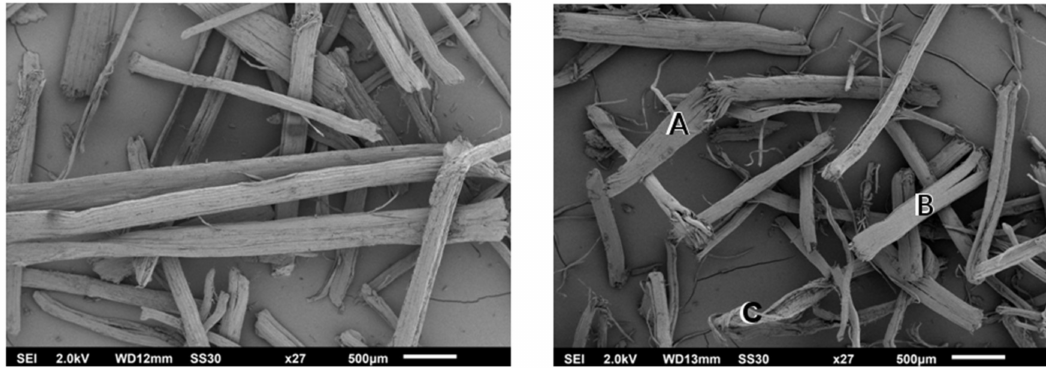
Figure 5. SEM pictures of sisal fibre bundles before ( left ) und after compounding ( right ). A: Fibre bundle breakage. B: Start of fibre bundle splitting. C: Peeling behaviour of sisal.